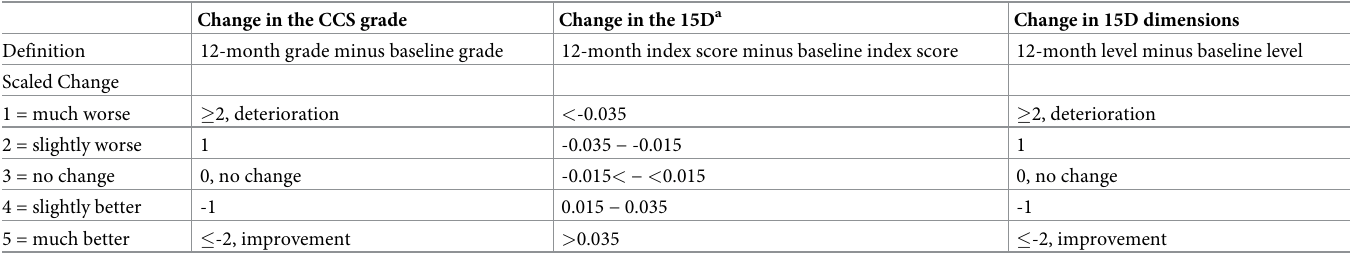
Table 1. Categorisation of changes in CCS and 15D.